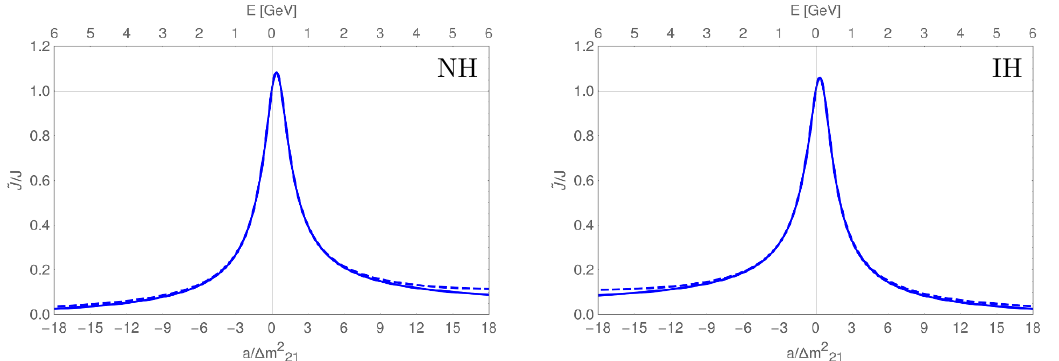
Figure 4 . ~ J = J ratio for both neutrinos ( a > 0) and antineutrinos ( a < 0). The horizontal axis shows both the evolution of the matter parameter a at (cid:12)xed energy (lower labels), i.e. changing the matter density, and as function of the energy if the constant density is chosen as that of the Earth mantle (upper labels). Both the exact (dashed) and the analytical (solid) results from eqs. (4.4) are shown. Normal Hierarchy in the left pannel, Inverted Hierarchy in the right